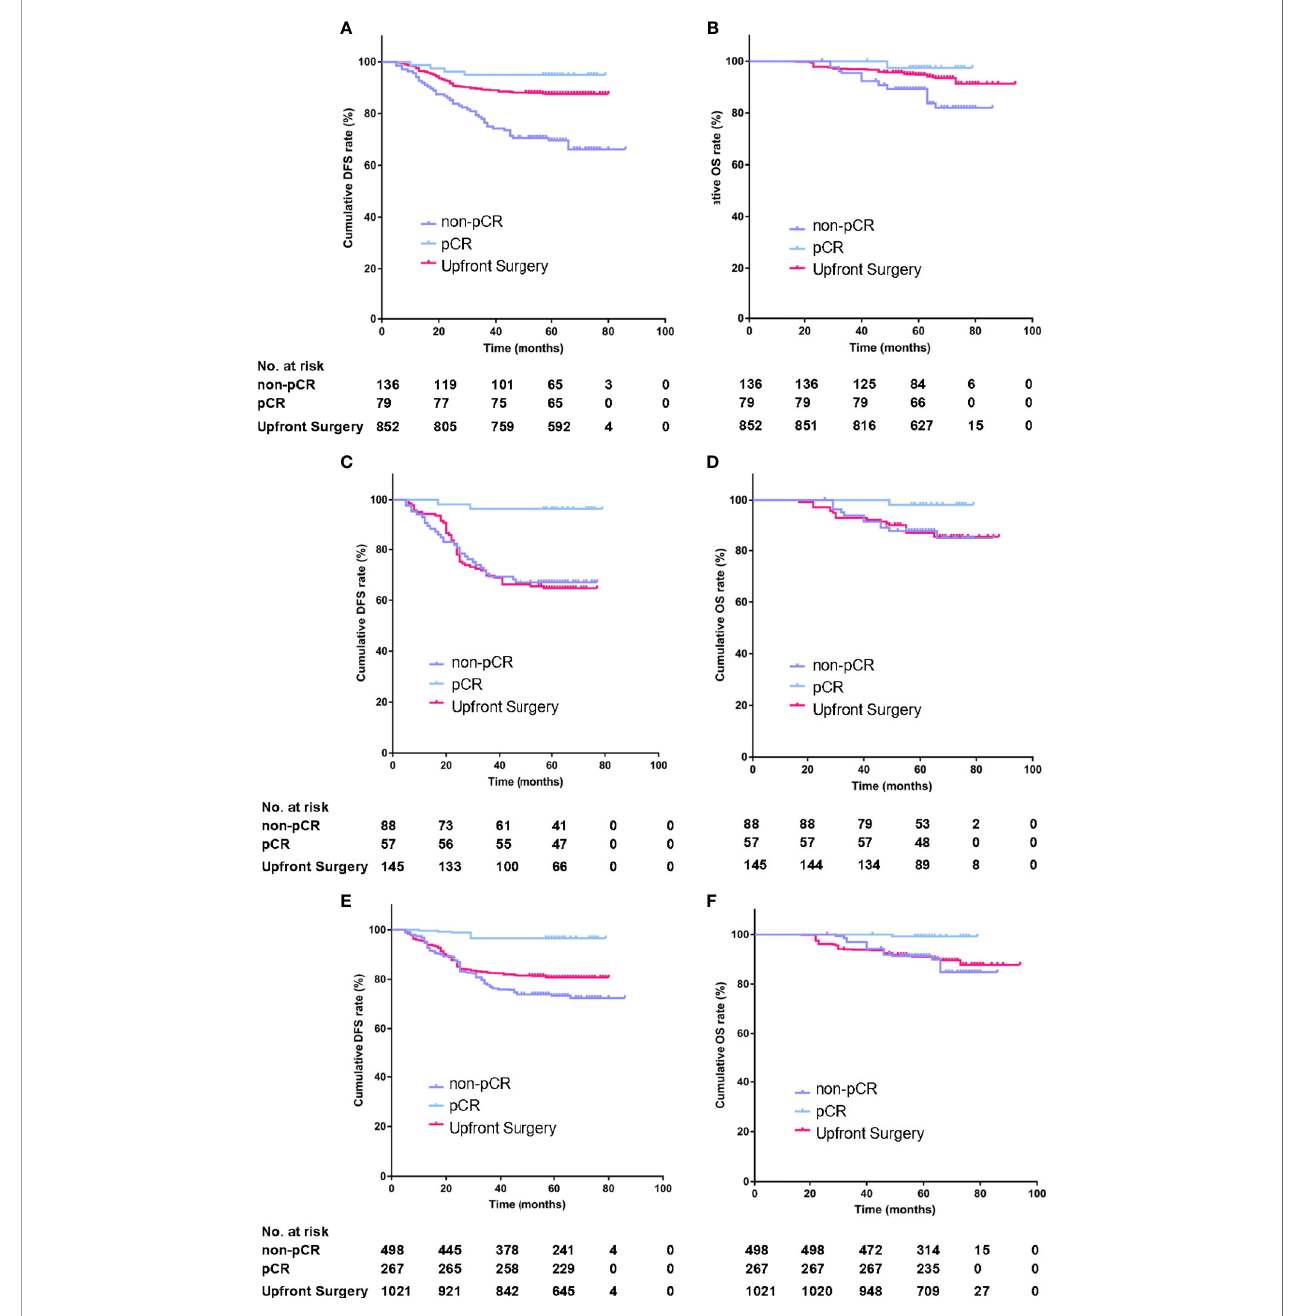
FIGURE 3 | The strati fi ed analysis of DFS and OS according to pathological response status in the PST group in primary unmatched model (A, B) in propensity score matching (PSM) model (C, D) , in inverse probability of treatment weighting (IPTW) model (E, F)